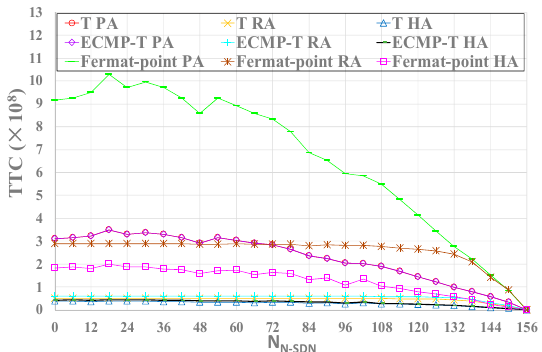
Figure 9. The impact of three approaches in three SDN interception models on TTC under CRN topologies. TTC. The lower, the better.